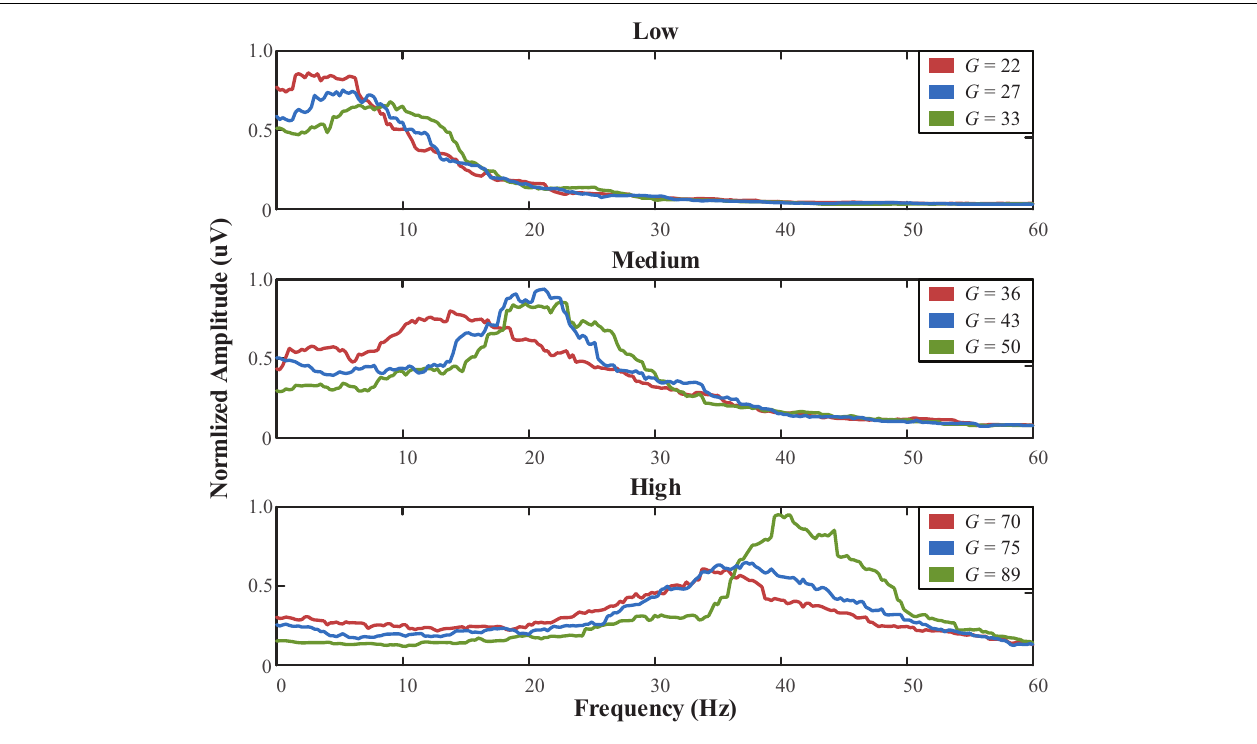
FIGURE 14 | Normalized spectrum of the low, medium, and high populations with varying G .